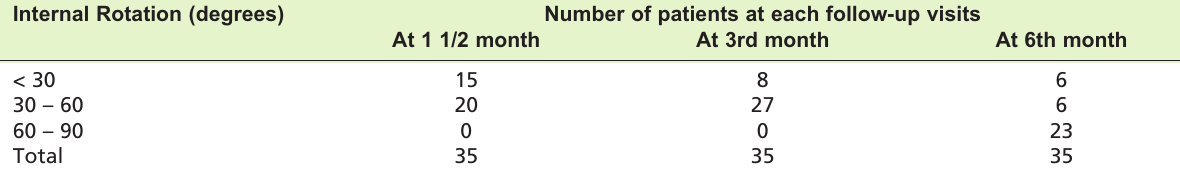
Number of patients in defined internal rotation range at each follow-up visit Table IV: Internal Rotation (degrees)